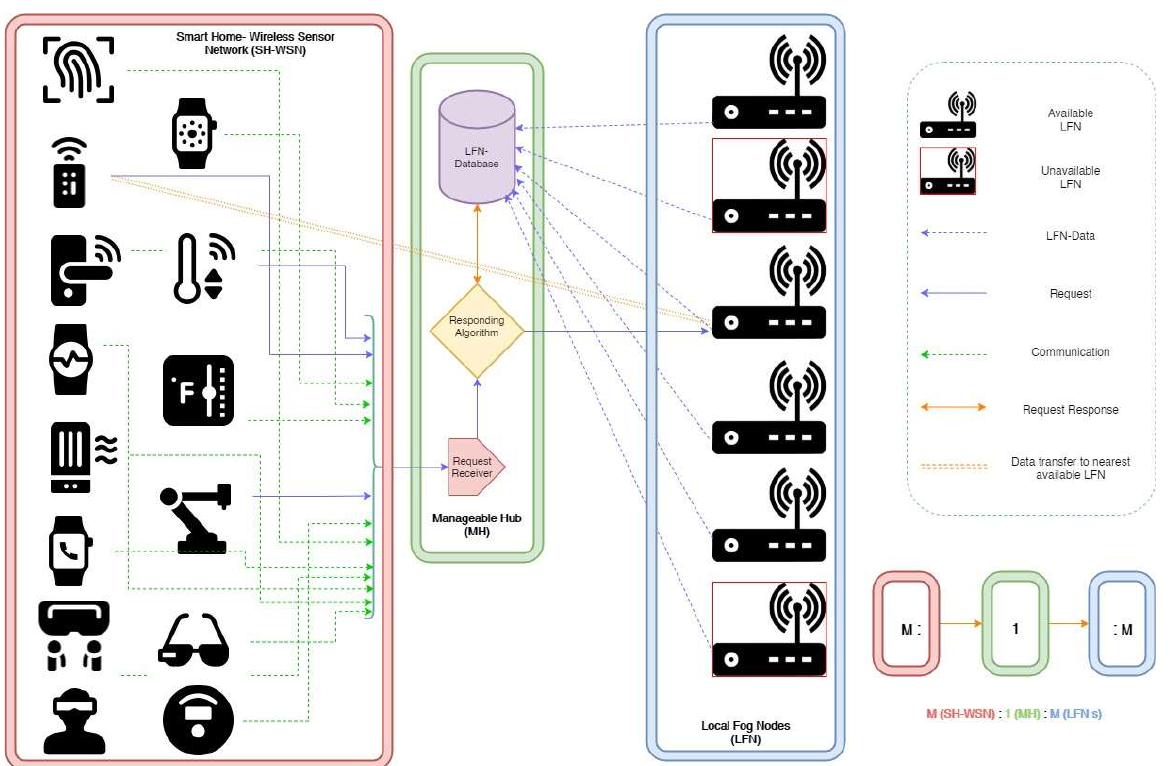
Figure 5. Communication through manageable hub (MH) and M:1:M (many-to-one-to-many rela- tionship) between different architectural components.